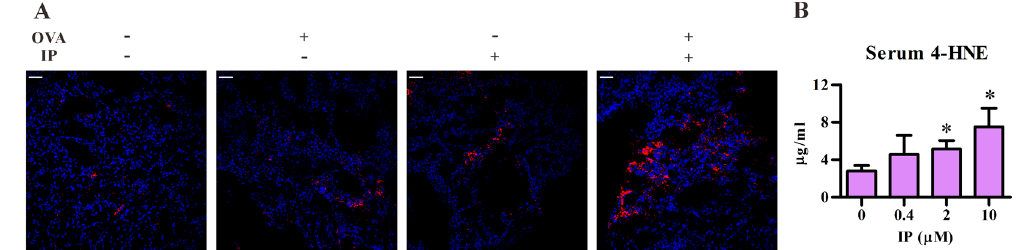
Figure 6. Detection of 4-HNE in lung tissues and in sera. ( A ) Frozen lung sections from treated mice as described in Fig. 3 were stained with DAPI (blue) and Cy3-conjugated 4-HNE Abs (red). The magnification: 200 × . ( B ) Serum levels of 4-HNE (mean ± SEM) in OVA immunized mice, as described in Fig. 2. Vehicle, n = 21; 0.4 μ M, n = 8; 2 μ M, n = 19; 10 μ M, n = 7. Scale bars represent 50 µ m in ( A ). * P < 0.05 vs. vehicle-treated group (Mann-Whitney U